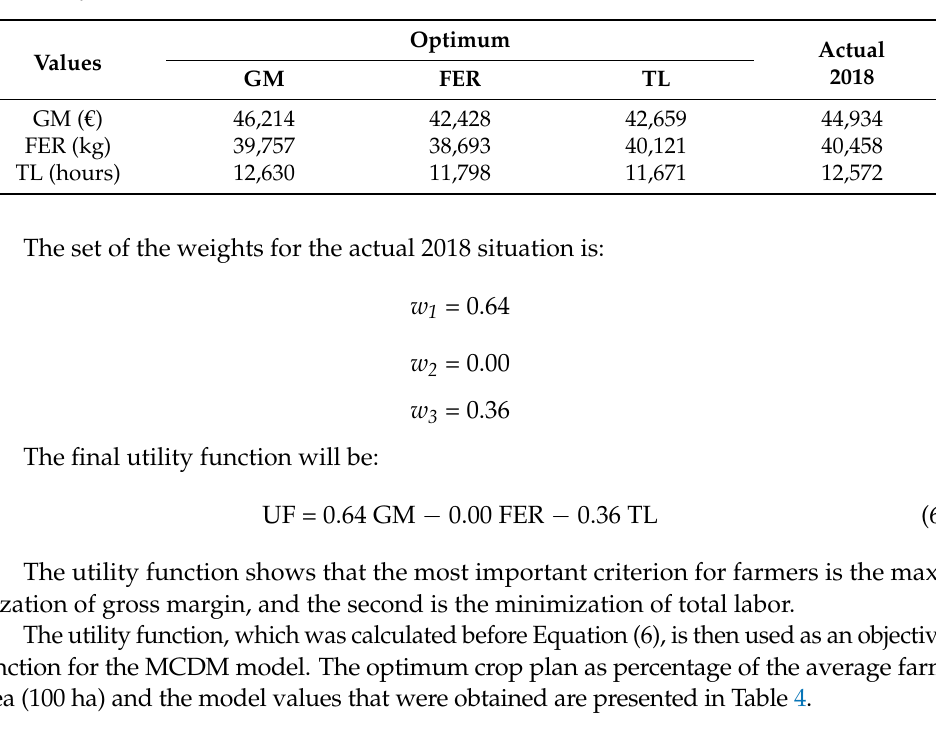
Table 3. Pay-off matrix of the MCDM model.